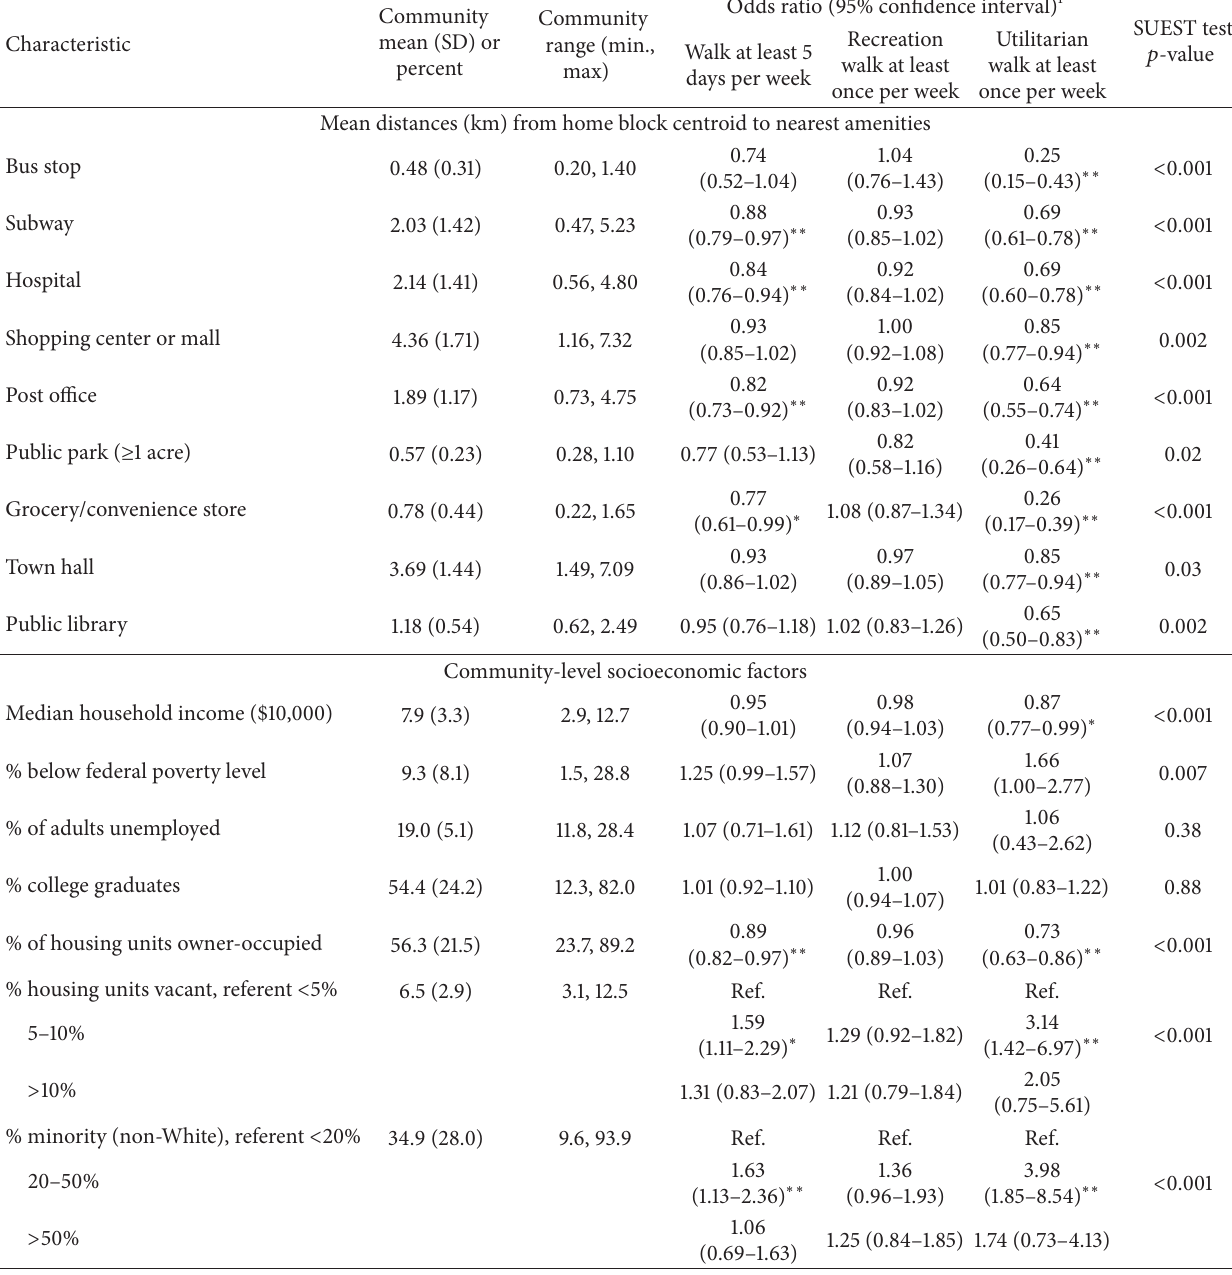
Table 2: Associations of three measures of walking with geographic access to amenities and community-level socioeconomic